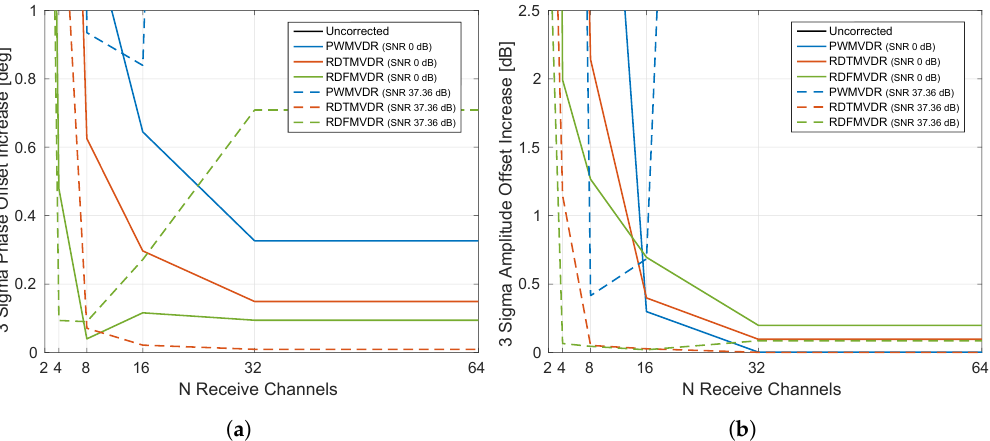
Figure 30. The 3 sigma error increaser of the residual error image of Scenario C at a RFI-Noise-Ratio of 40 dB vs. the antenna array length. The plots are shown for SNR = 0 dB (solid lines) and SNR = 37.36 dB (dashed lines). ( a ) Phase offset, ( b ) Amplitude